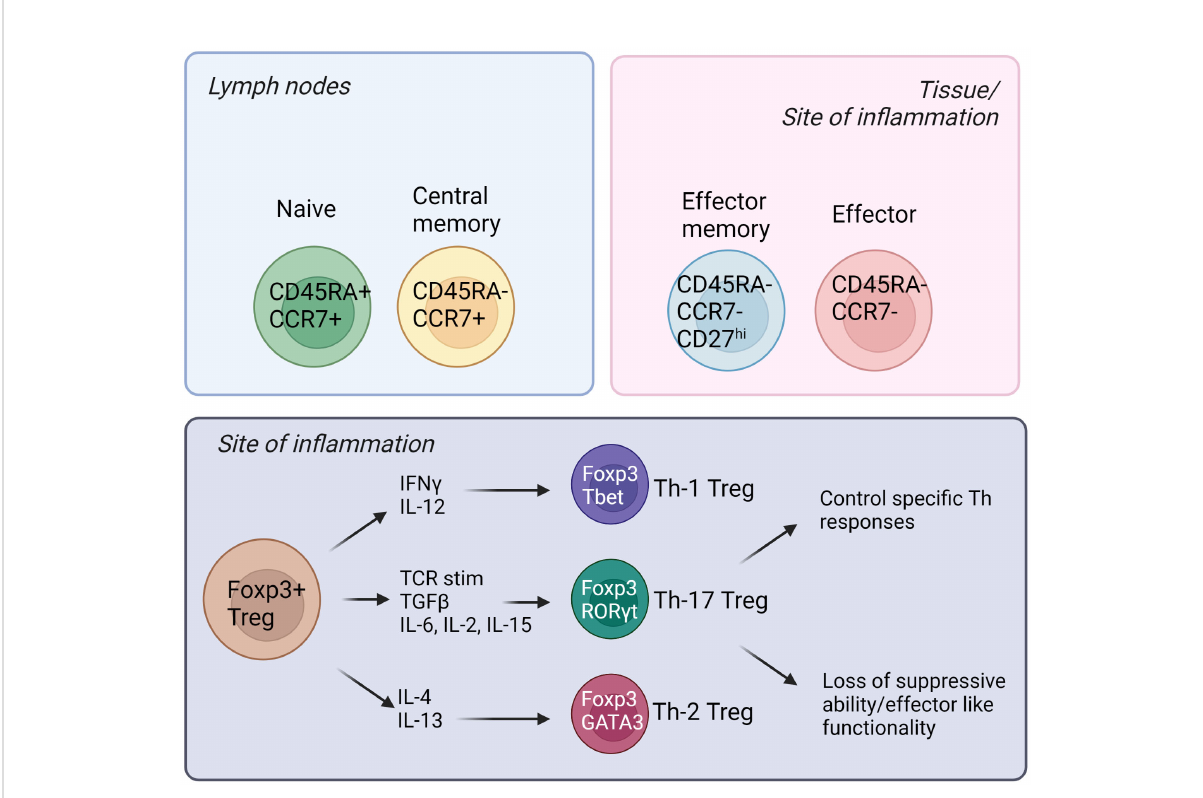
FIGURE 1 Different subsets of human Tregs in the lymph nodes, tissues, and sites of in fl ammation. Tregs emerge from the thymus and migrate into secondary lymphoid organs. Naïve and central memory Tregs reside in the lymph nodes while effector memory and effector Tregs can be found in the tissues and sites of in fl ammation. (Created by